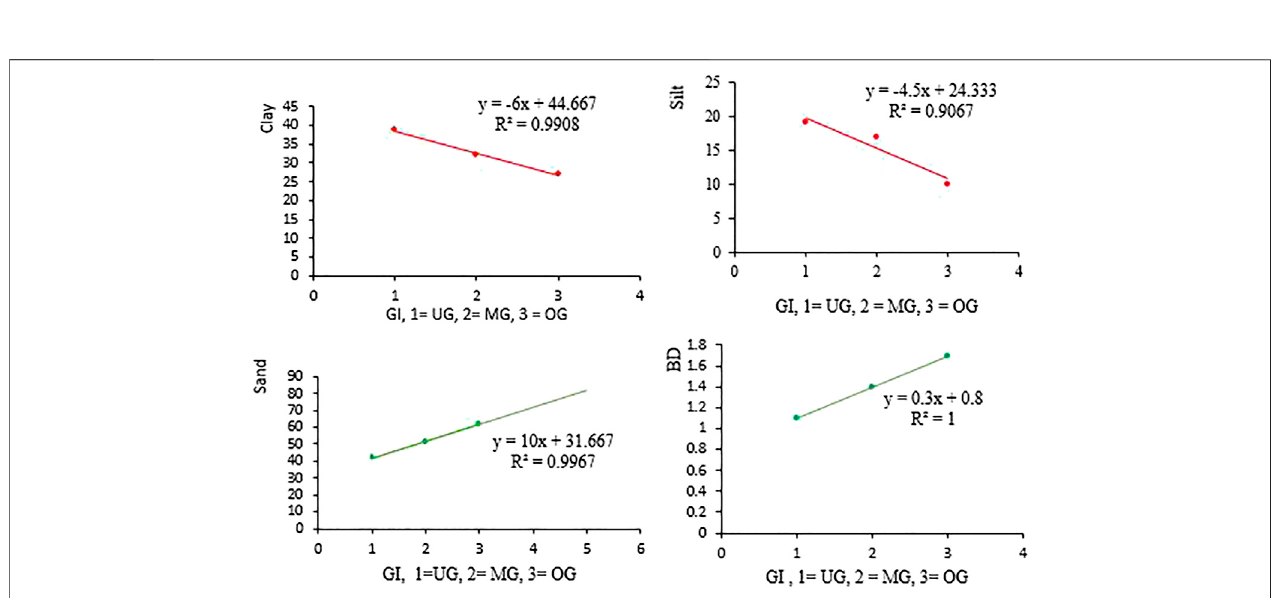
FIGURE 5 | Correlations between soil physical properties and grazing intensity. GI, grazing intensity; NG, non-grazing; MG, moderately grazing; OG, overgrazing.